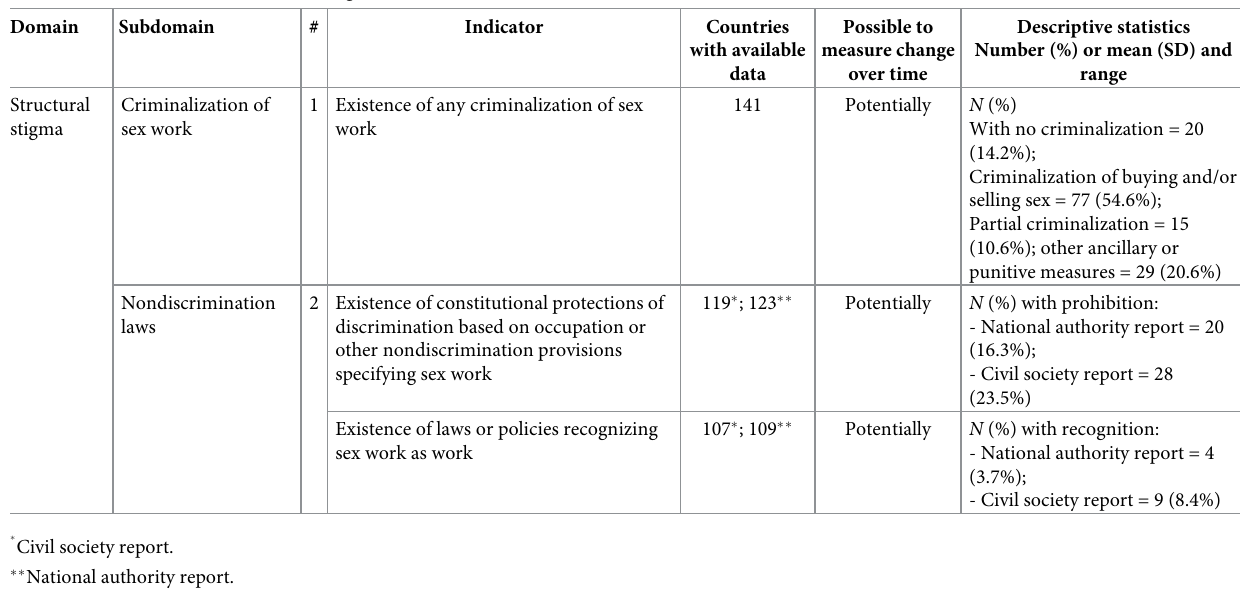
Table 4. Final indicators for sex work